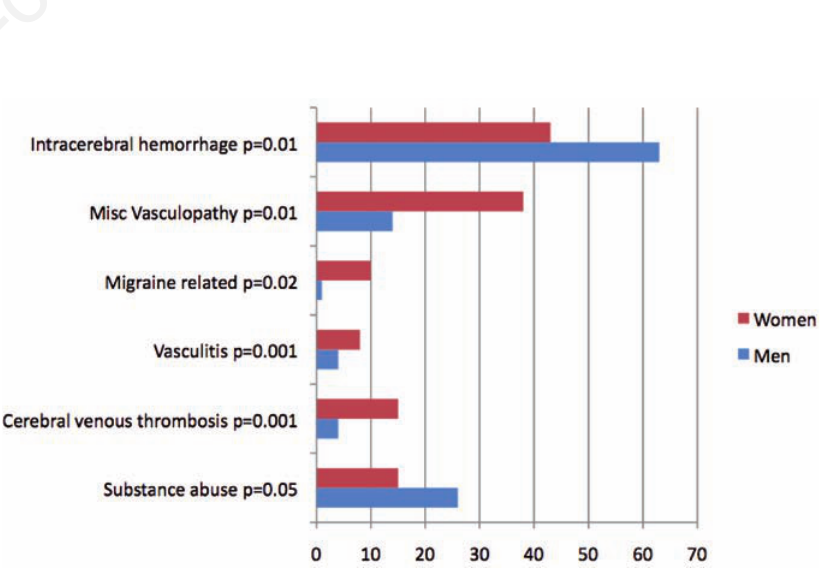
Figure 2. Stroke Etiology in the expanded other category (Y axis: etiology, X axis: number of